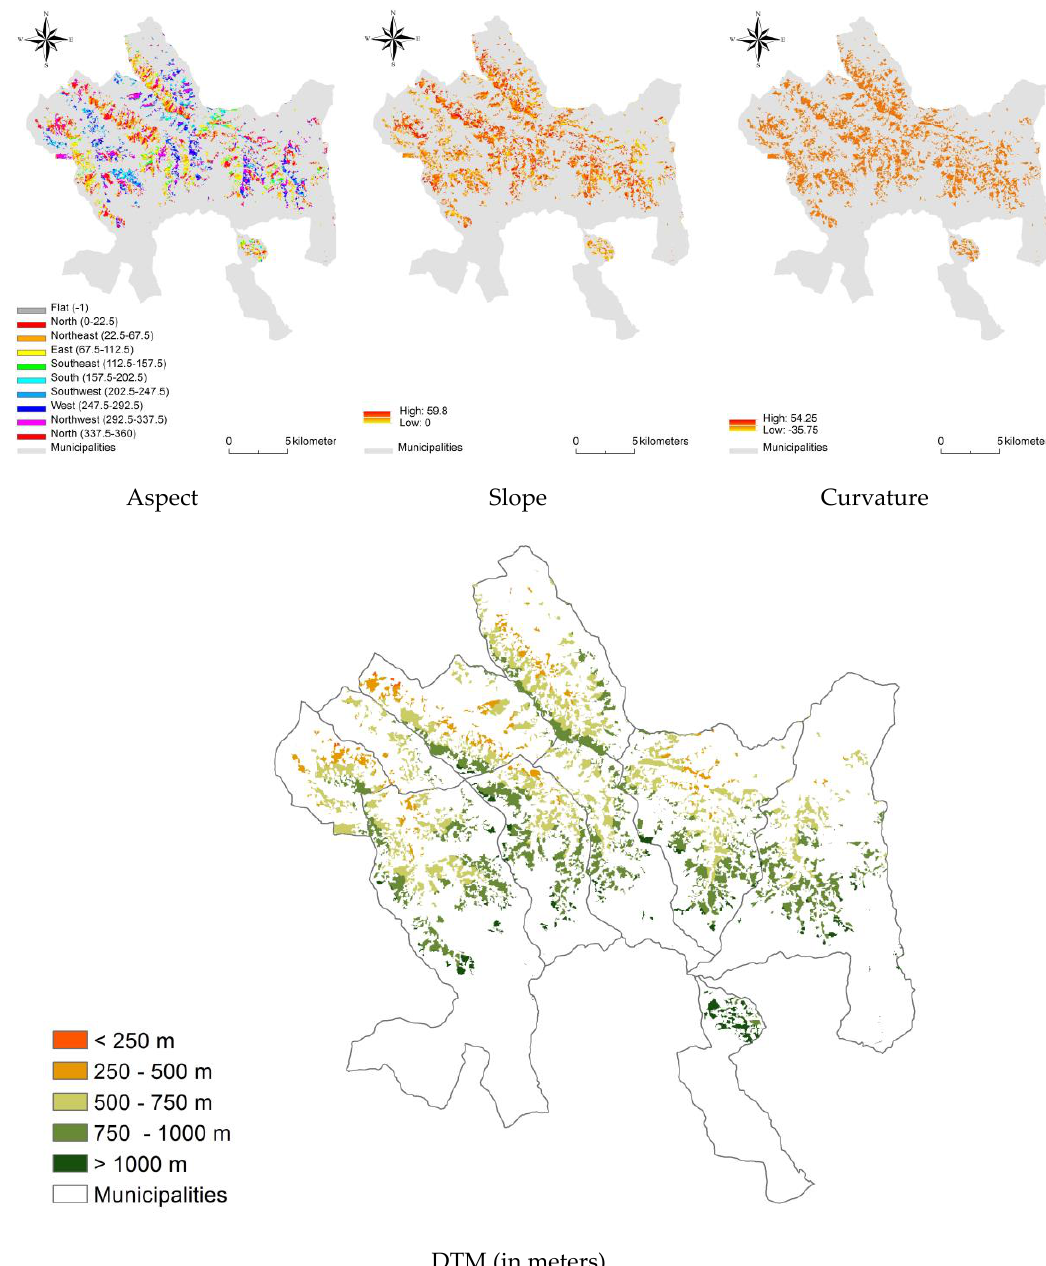
Figure 3. Morphological structures of the territory using GIS program. Source: own elaboration.